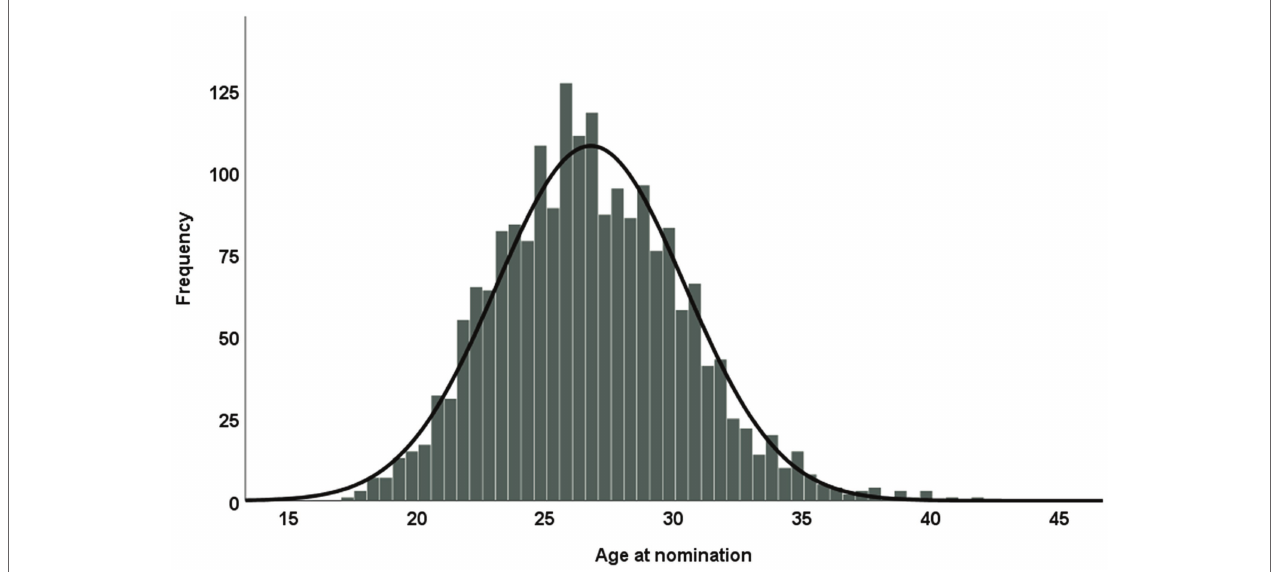
FIGURE 1 | Frequency of nominations at different ages for the total sample.